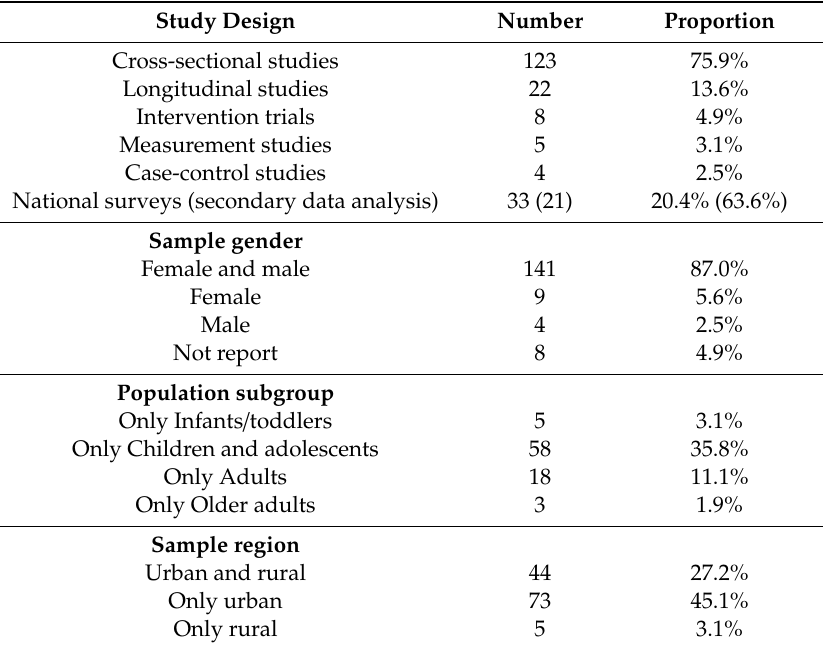
Table 1. Characteristics of the study design and